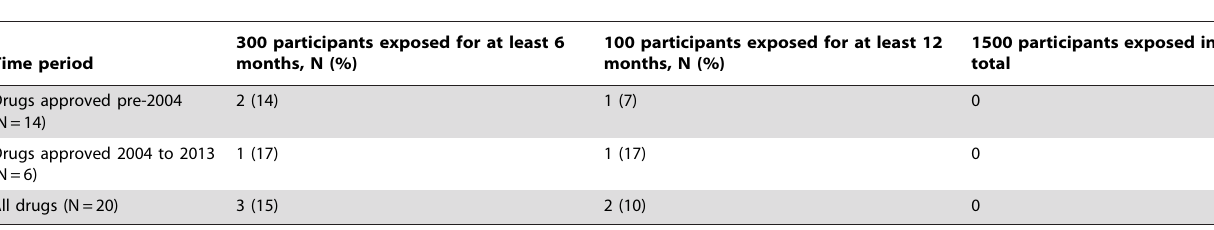
Table 3. Compliance of pre-approval ADHD clinical drug trials with ICH guidelines overall and during past 10 years.